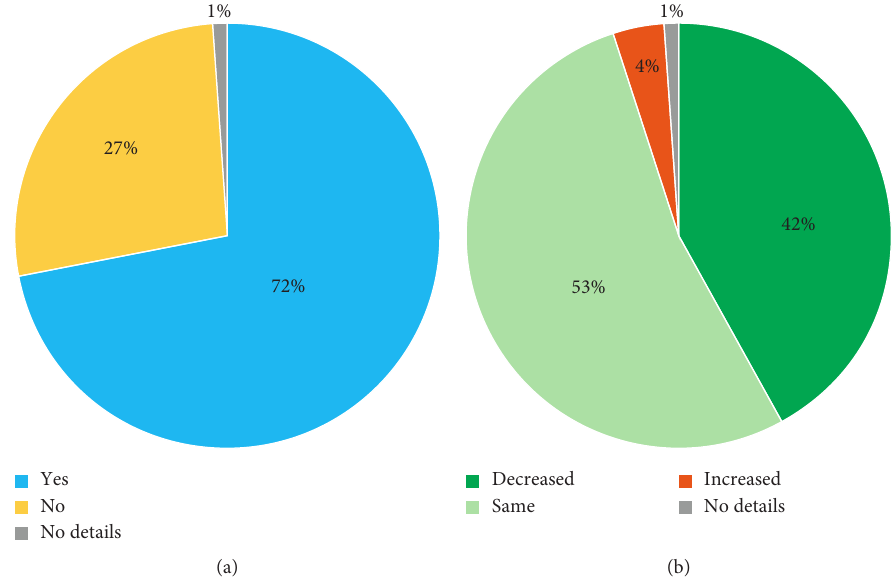
Figure 3: Improvement in function (a) and change in medication (b) at the 6-month follow-up visit ( N � 101